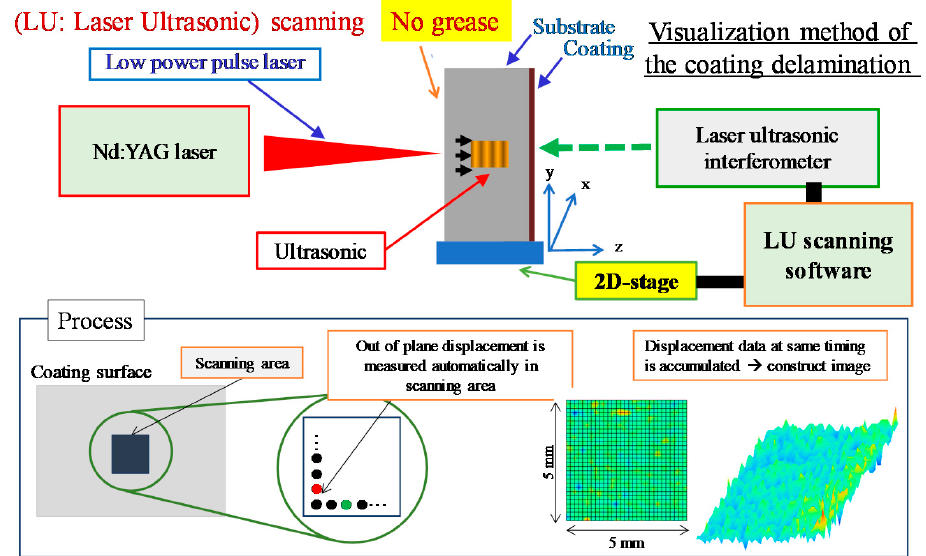
Figure 3. Overview of LUS for delamination identification.